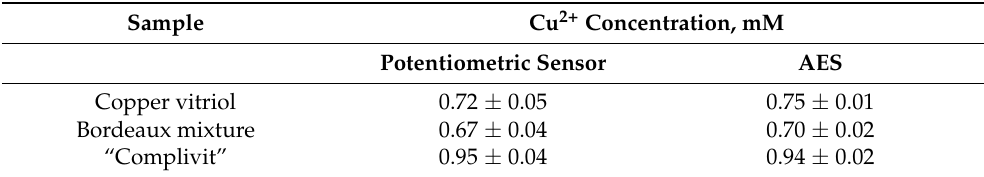
Table 5. The determination of Cu 2+ in real samples with potentiometric sensor based on polyaniline and P[6]A–Cu 2+ -layered coating, nominal concentration 1.0